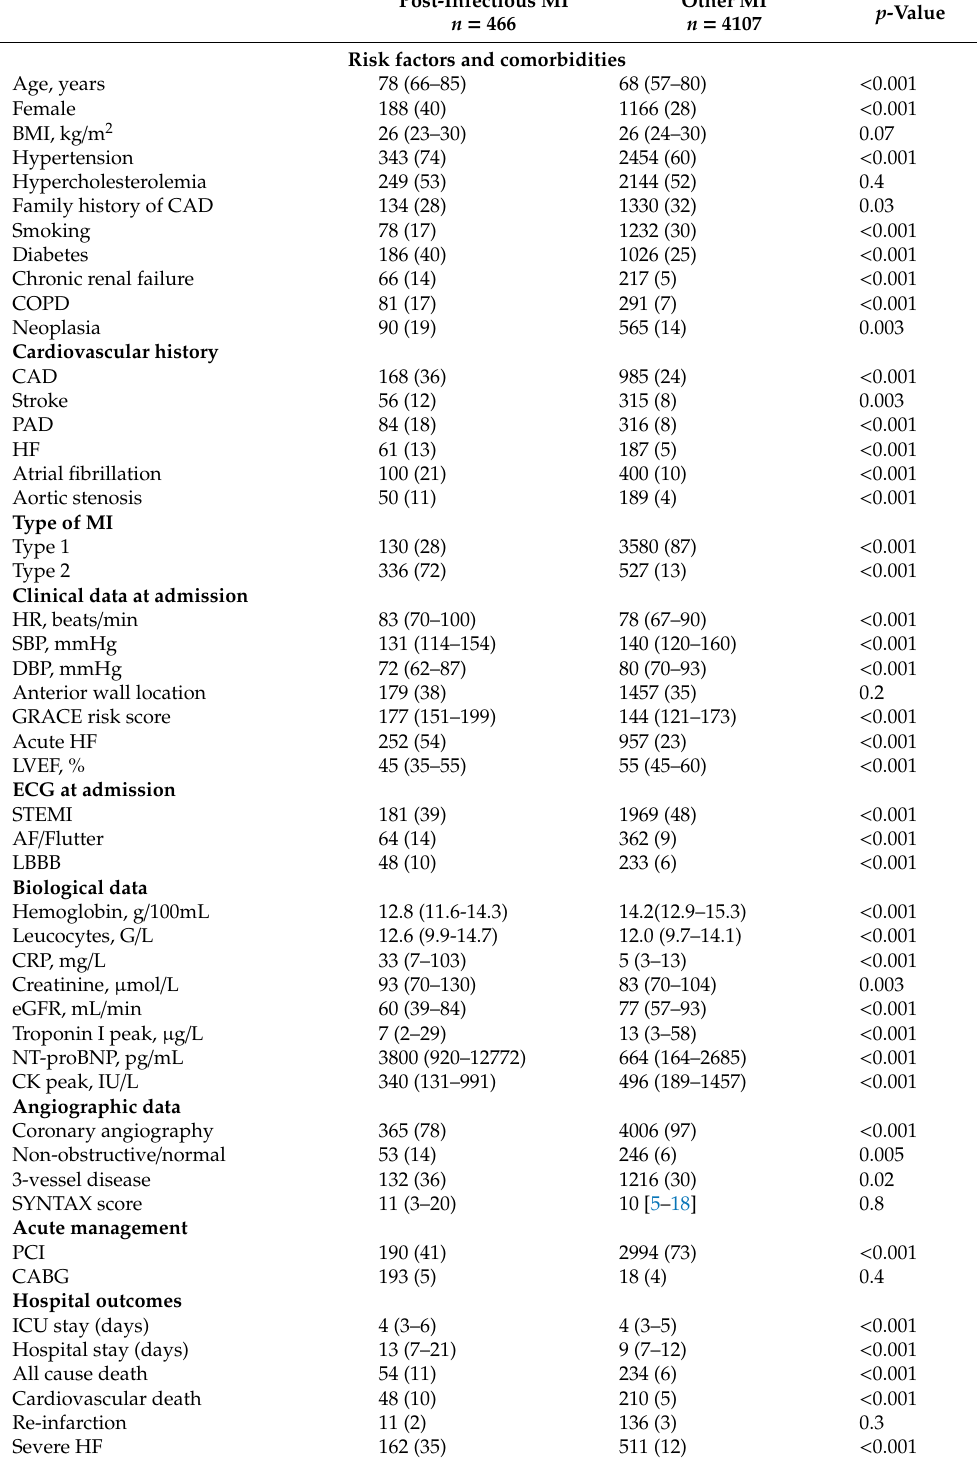
Table 1. Patients characteristics on admission ( n (%) or median